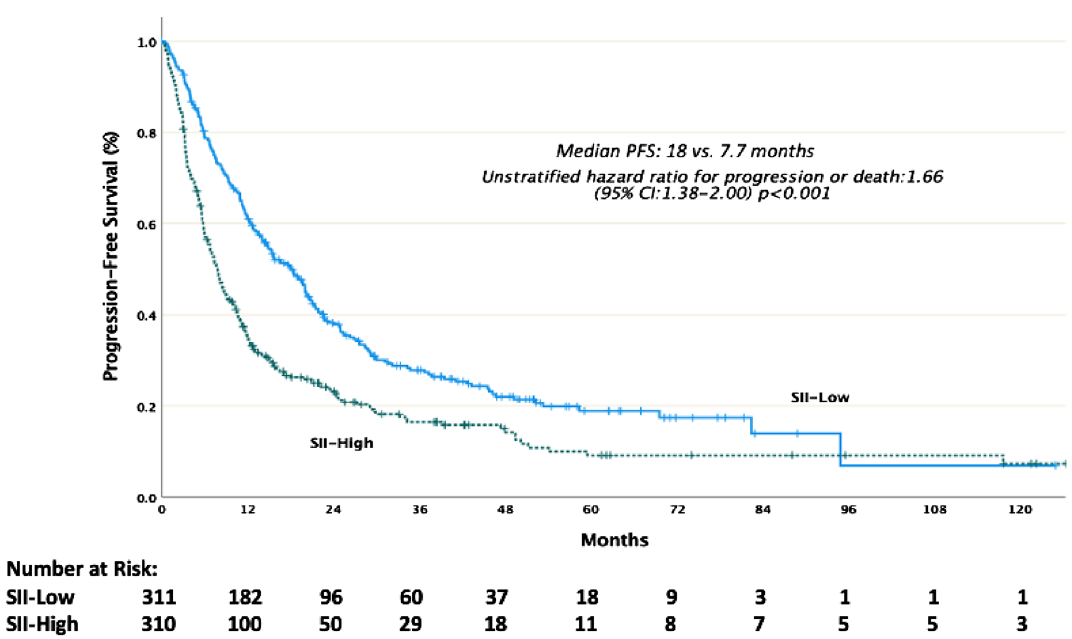
Figure 2. Kaplan-Meier estimates of progression-free survival (PFS). SII systemic immune inflammation